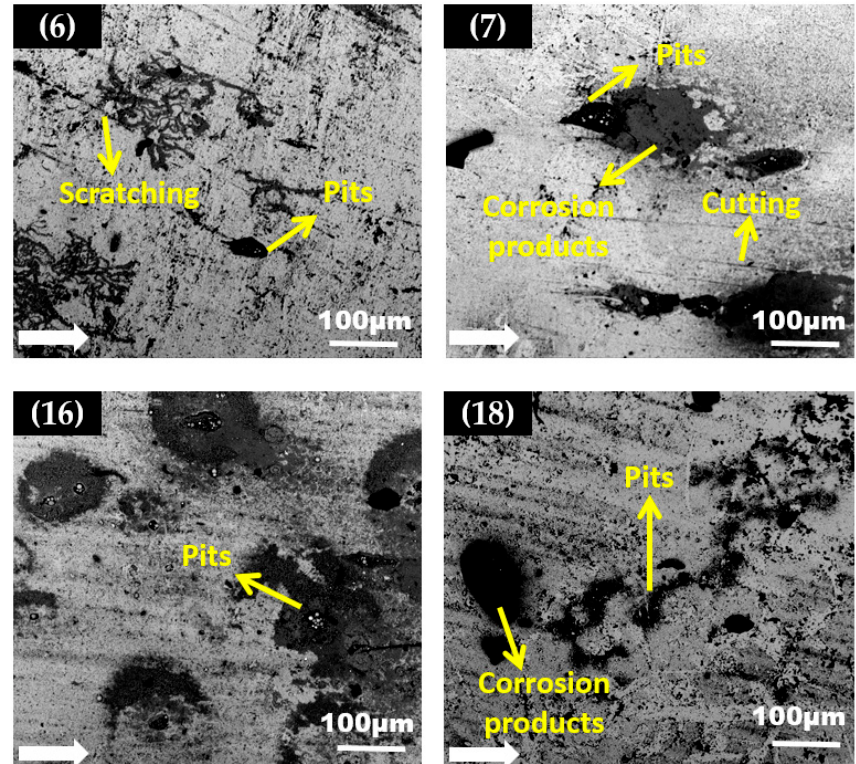
Figure 10. The backscattered electron (BSE) images of a carbon steel 90° elbow after the test.